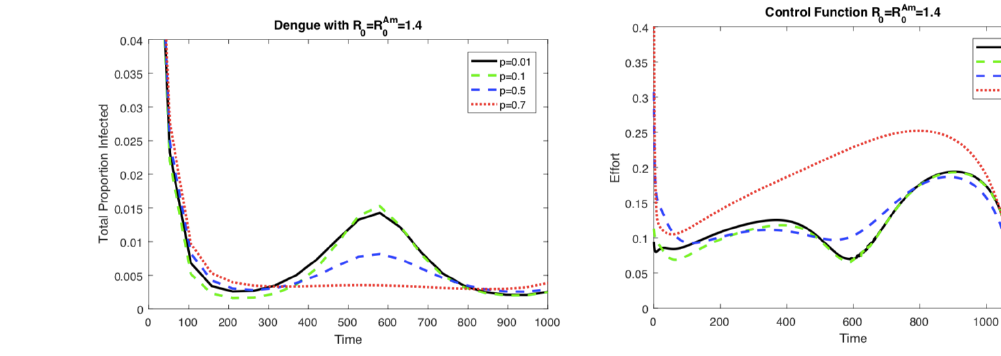
( a ) Proportion of the total population infected with ( b ) The effort is the percentage of all infections either strain DENV-2 American or DENV-2 Asian when prevented when the dominant strain is DENV-2 American, β Am = 0.194 and β As = 0.195 − 0.105. the dominant strain is DENV-2 American, β Am = 0.194 and β As = 0.195 − 0.105 Figure 5. When the dominant strain is DENV-2 American, as the level of vertical transmission increases, the level of optimal control increases ( b ). Therefore, it is easier to control the outbreak ( a ).